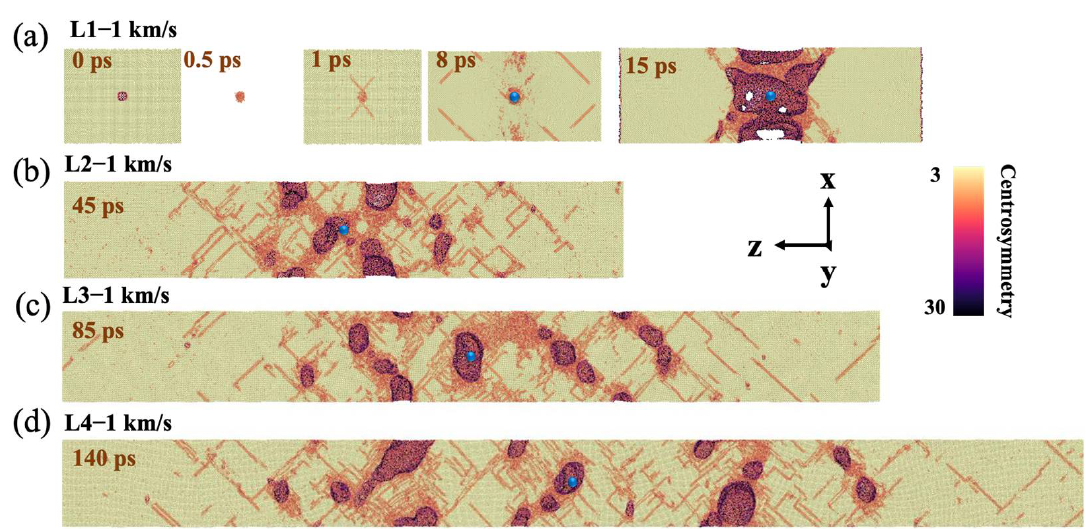
Figure 8. Microscopic views of void evolution and damage for ( a ) L1, ( b ) L2, ( c ) L3, and ( d ) L4 at v 0 = 1 km/s. The microscopic views were sliced from the center axis, and atoms with centrosymmetry values less than 8 were deleted. The blue ball represents the preset void position.